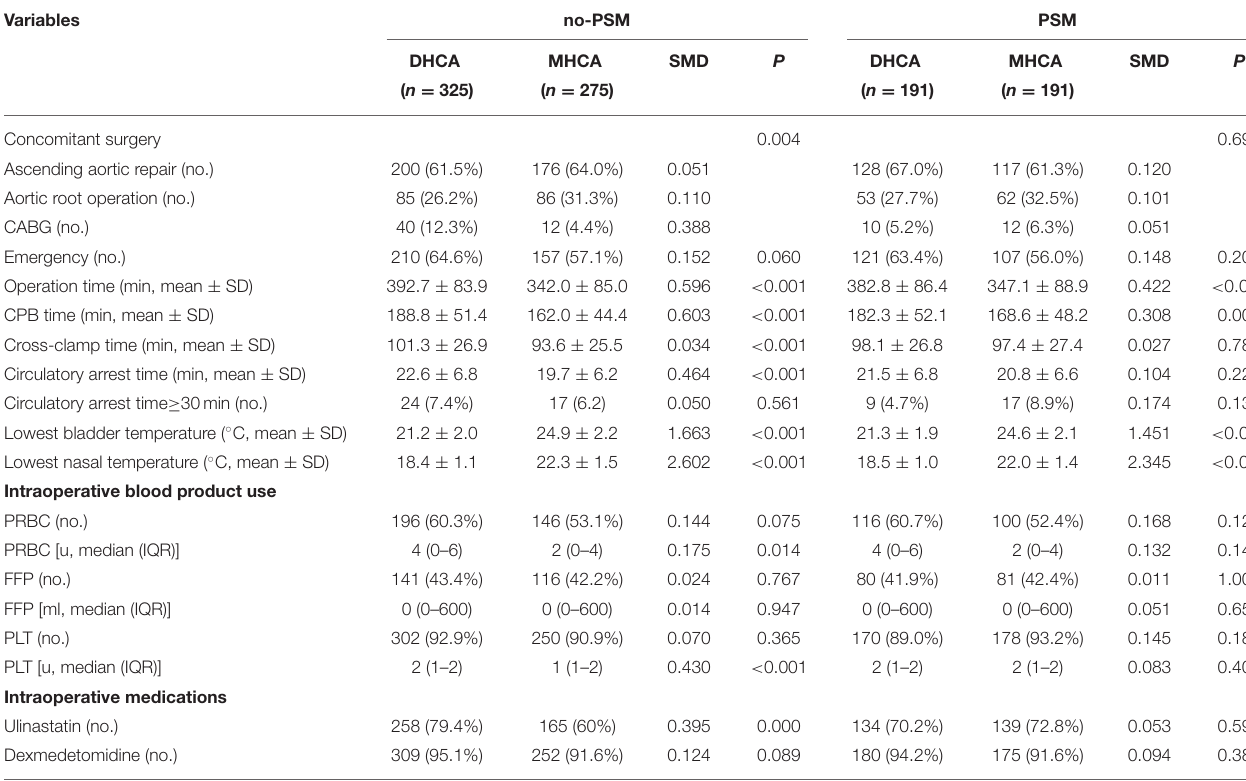
TABLE 3 | Operative